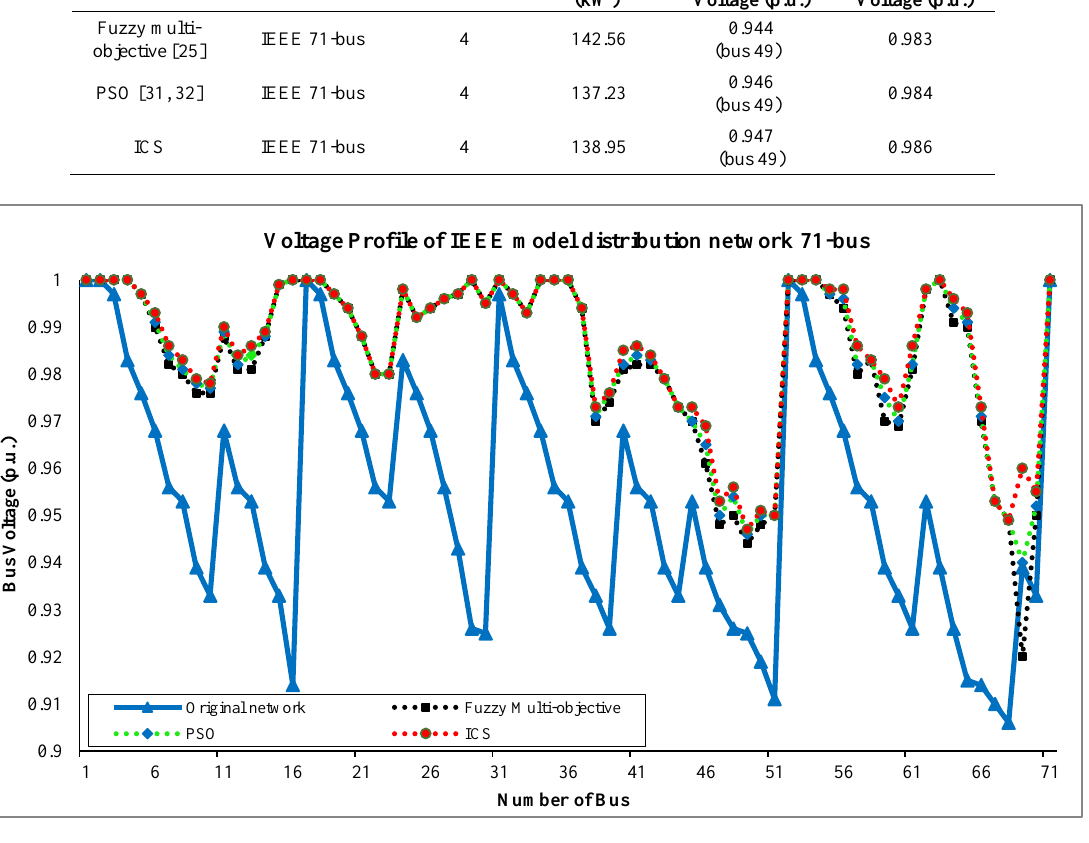
Figure 16. Comparison of voltage profile of the proposed ICS method with fuzzy multi-objective and PSO